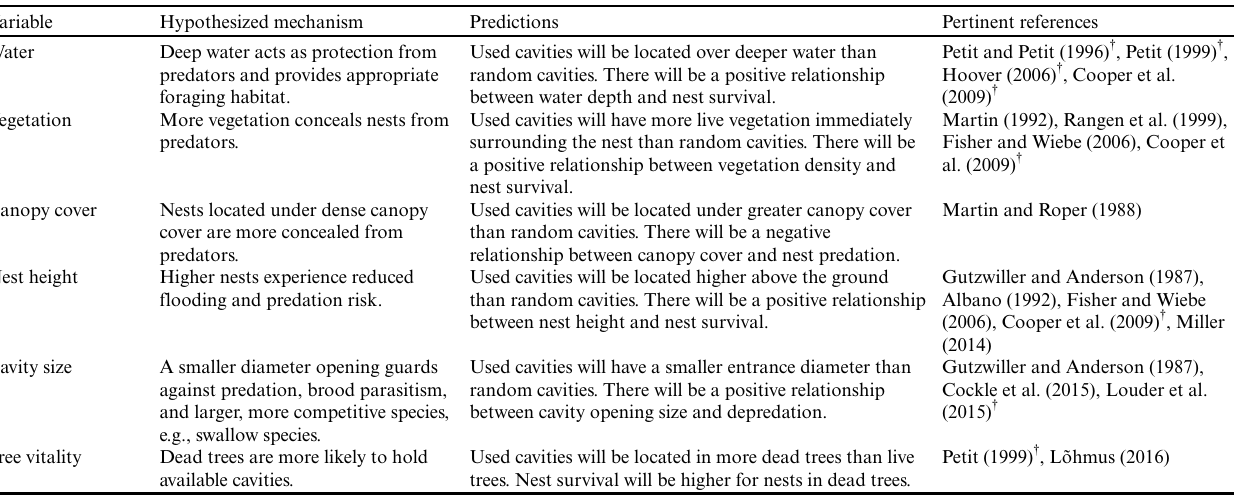
Table 1 . Summary of a priori, nonmutually exclusive hypotheses that may explain the relationship between microhabitat characteristics and (a) habitat selection and (b) nest survival of Prothonotary Warbler ( Protonotaria citrea ) nests in White River National Wildlife Refuge, Arkansas, USA in